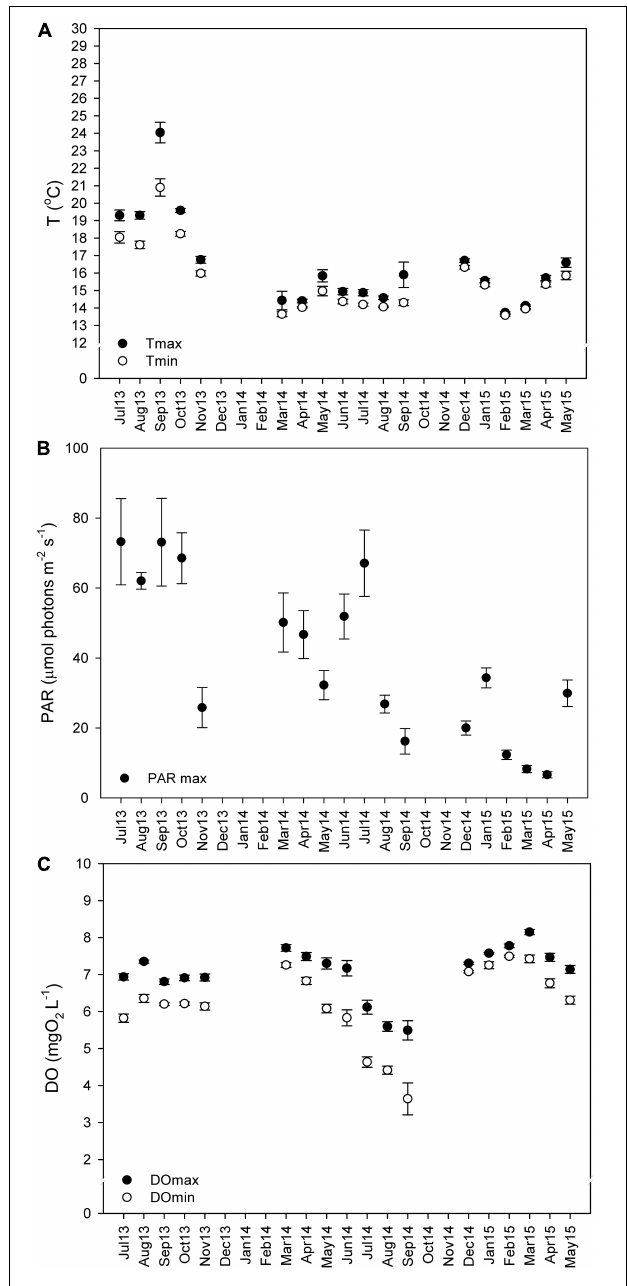
FIGURE 2 | Monthly average of daily maximum and minimum temperatures ( A , ◦ C), photosynthetically active radiation (PAR) ( B , µ mol m − 2 s − 1 ), and dissolved oxygen (DO) concentrations ( C , mg L − 1 ). Values from summer 2013 (Jul 13–Aug 13), autumn 2013 (Sep 13–Nov 13), winter 2013–2014